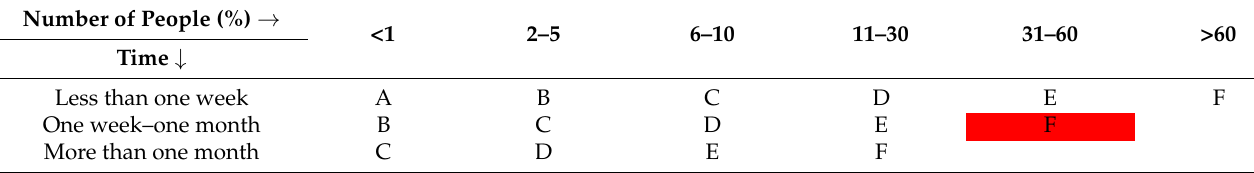
Table A7. Percentage of people affected by daily disruption [24].